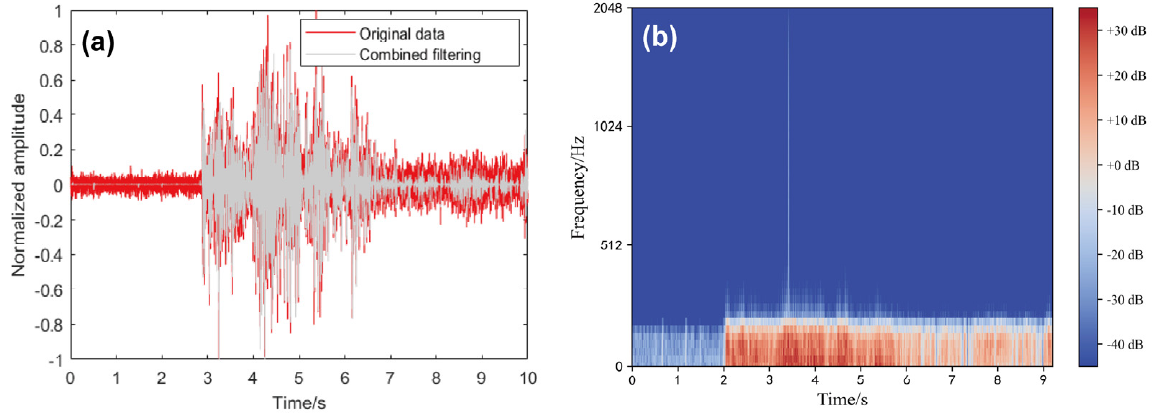
Figure 8. ( a ) The waveform and ( b ) spectrogram of the original signal and that filtered using combined spectral subtraction and a low-pass filter for the thunder initiated at 14 km. Table 1. Comparison of signal-to-noise ratios of the thunders filtered using different methods. Distance